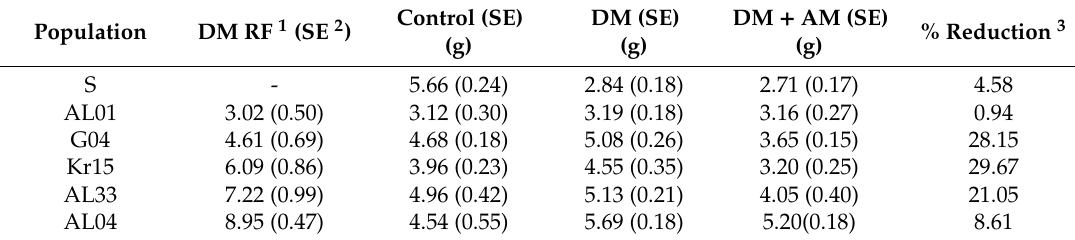
Table 7. Fresh weight of six populations of P. brachystachys with treatments of DM and DM + Amitrol